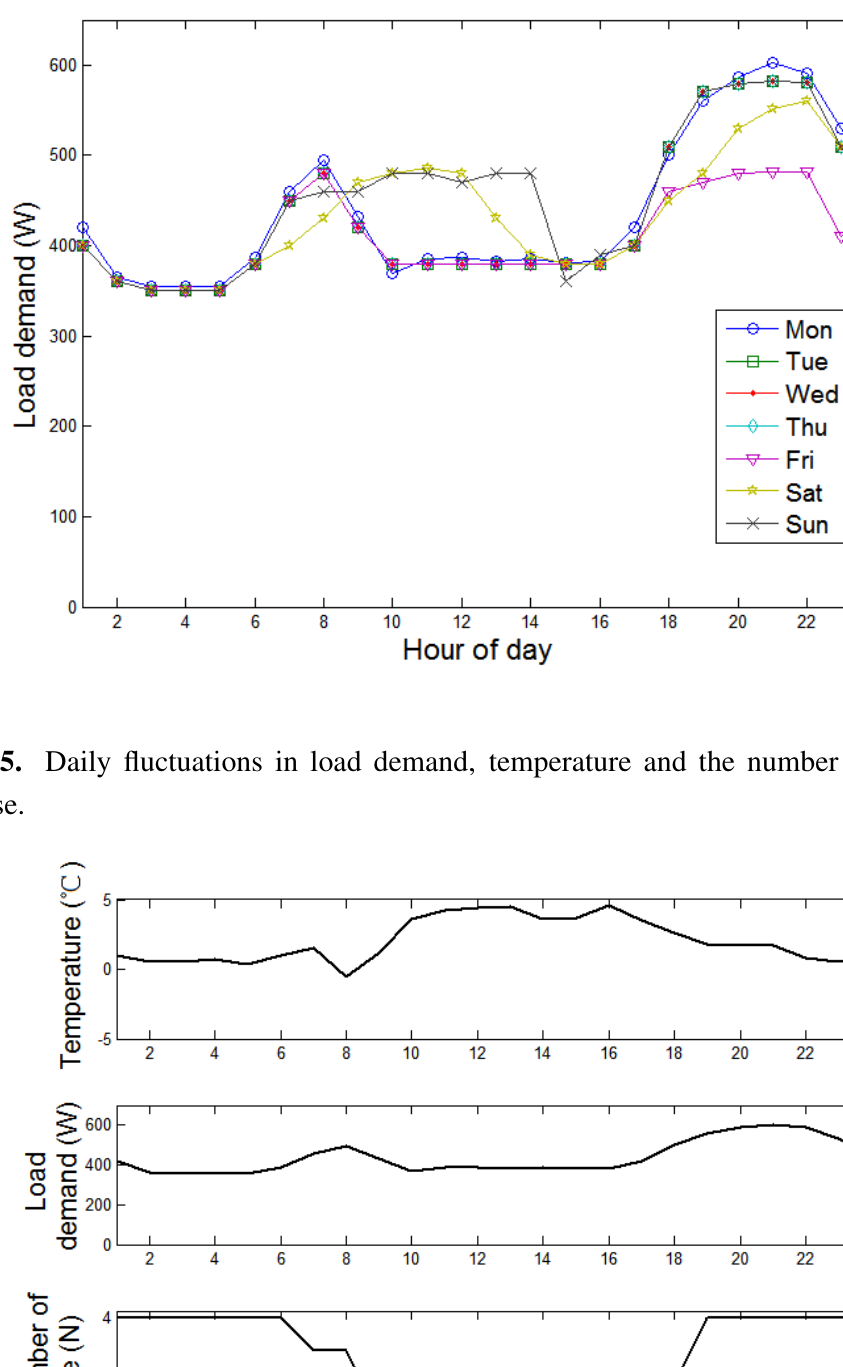
Figure 4. Daily fluctuations in load for the week.